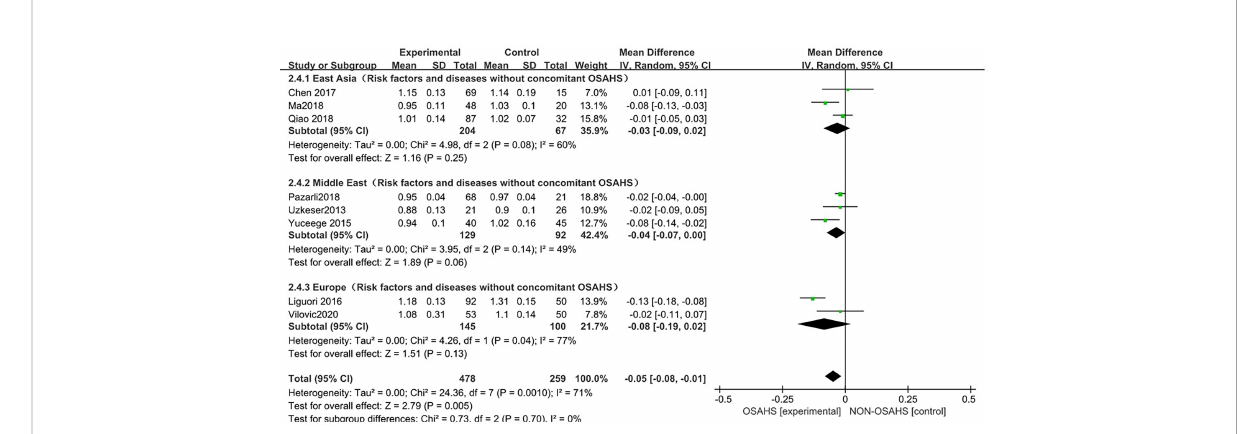
FIGURE 7 Forest plot of subgroup analysis of lumbar spine BMD in OSAHS group and control group (after excluding risk factors related to